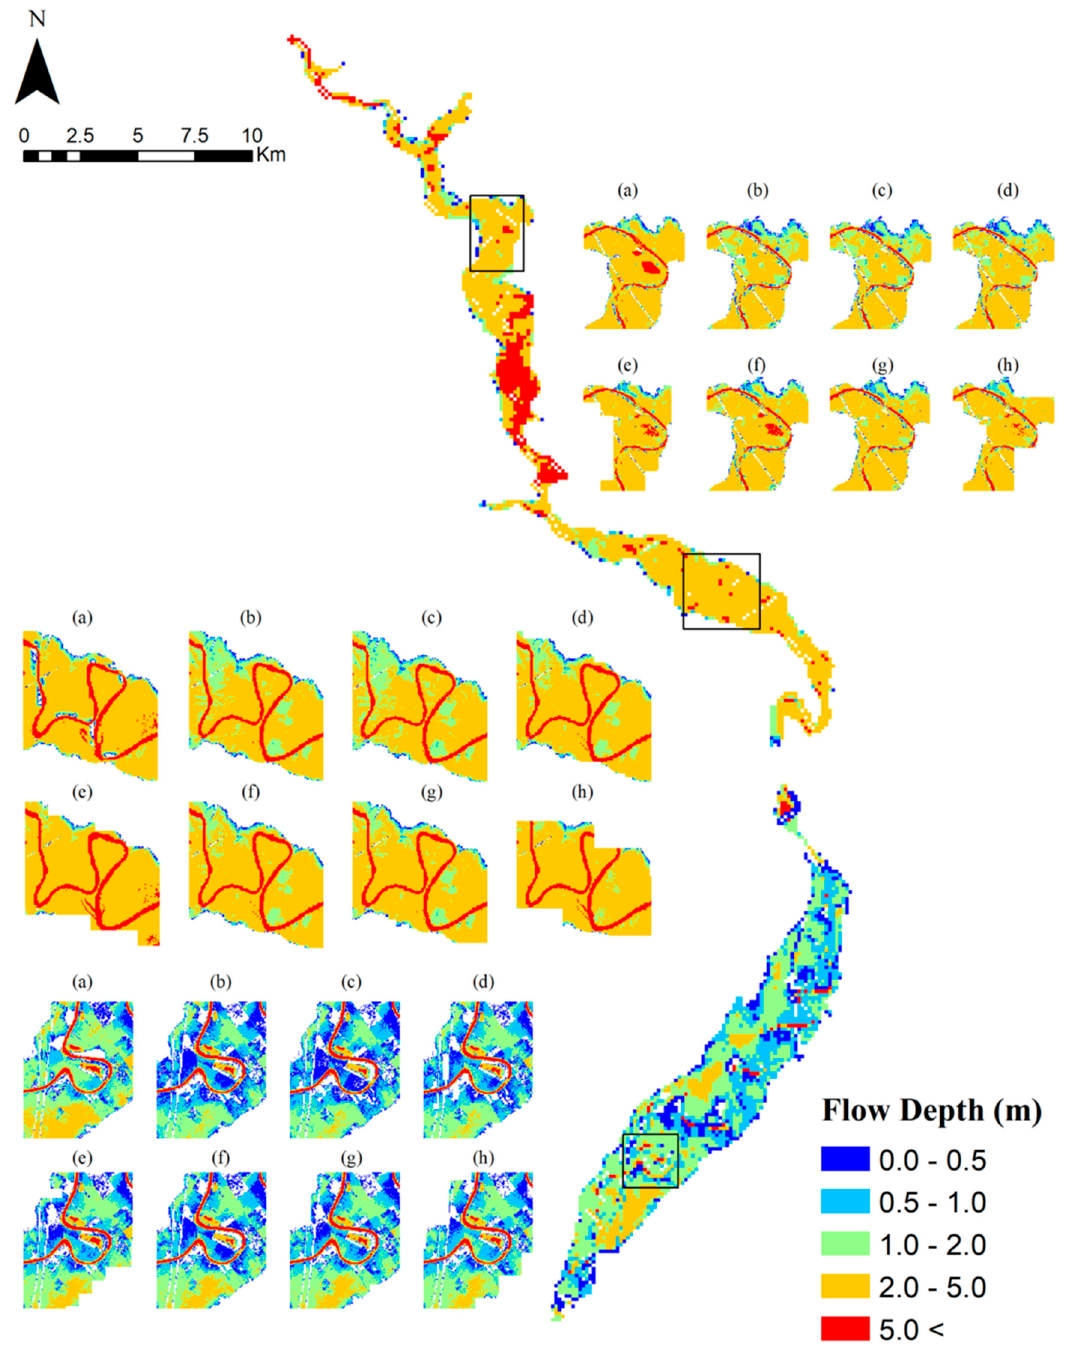
Figure 9. Distribution of inundation flow depths of the reference model at 150 m resolution (full scale map) and three selected subdomains where inundation depths are depicted using the postprocessing geospatial algorithm for visualizing the different flood modelling scenario at 30 m model resolution comparing ( a ) reference model; ( b ) 150 m; ( c ) 200 m; ( d ) 300 m; ( e ) 400 m; ( f ) 500 m; ( g ) 600 m; and ( h ) 700 m.